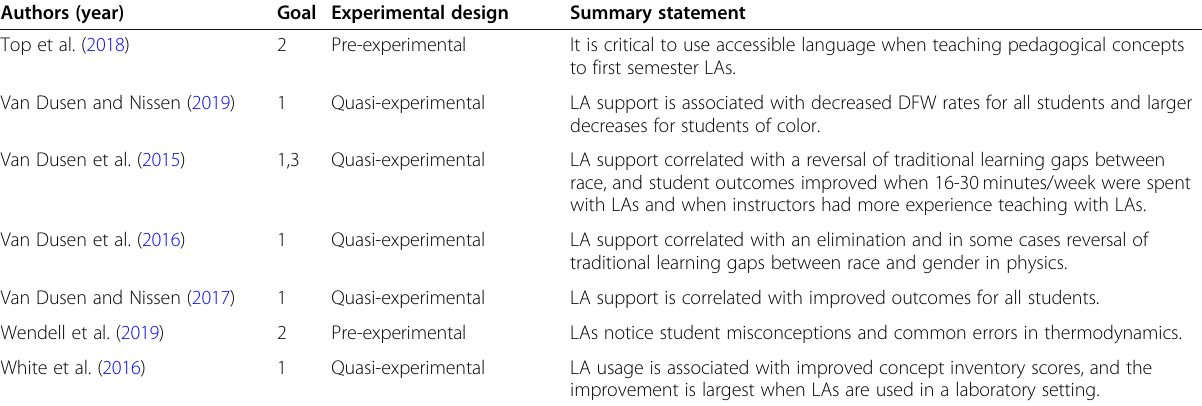
Table 1 A summary of studies referenced in this paper that assess one or more of the original goals of the LA model (see text for details of goals)